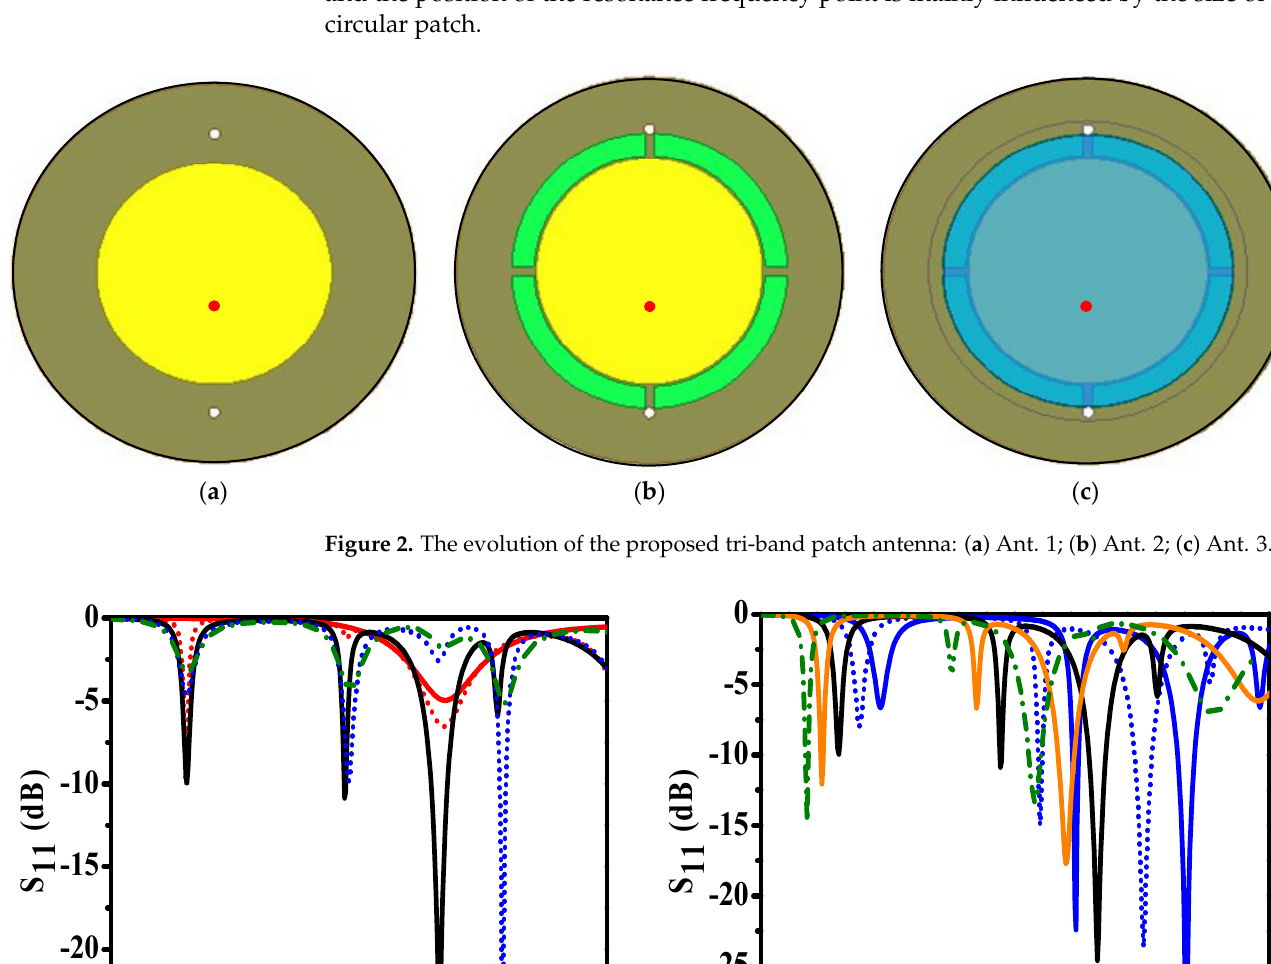
Figure 1. Geometry of the proposed patch antenna: ( a ) top view of Substrate 1; ( b ) top view of Sub- strate 2; ( c ) side view of the proposed antenna. R1 = 48, R2 = 32, R3 = 27, R4 = 26.25, R5 = 33, R6 = 38, d = 9.8, lg = 4, H1 = 1.5, H 2 = 0.5, H3 = 1.1 (all dimensions in mm).